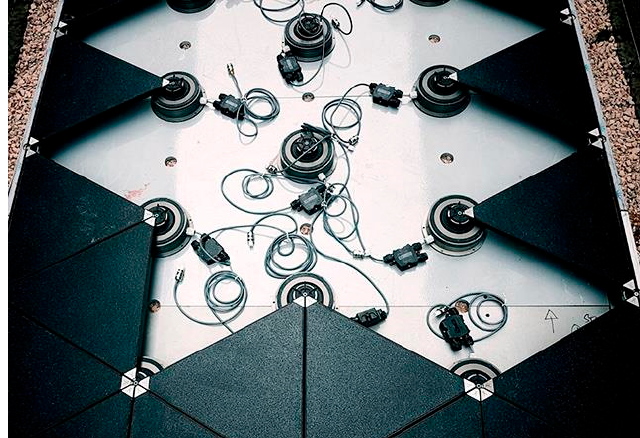
Figure 31. Detail of installation of the tiles.